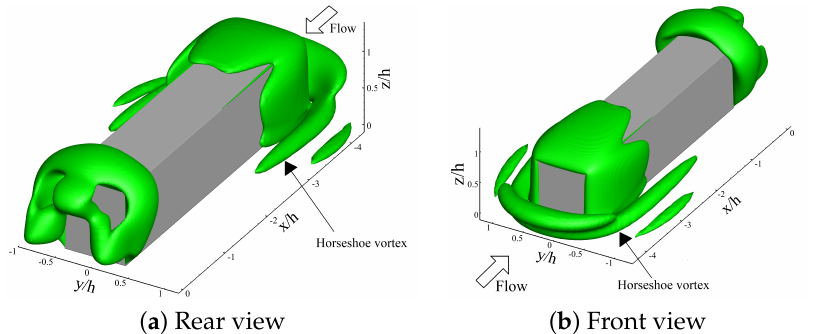
Figure 12. The isosurface of Q ∗ = 4.42 × 10 − 2 in the wake of the long rectangular prism.